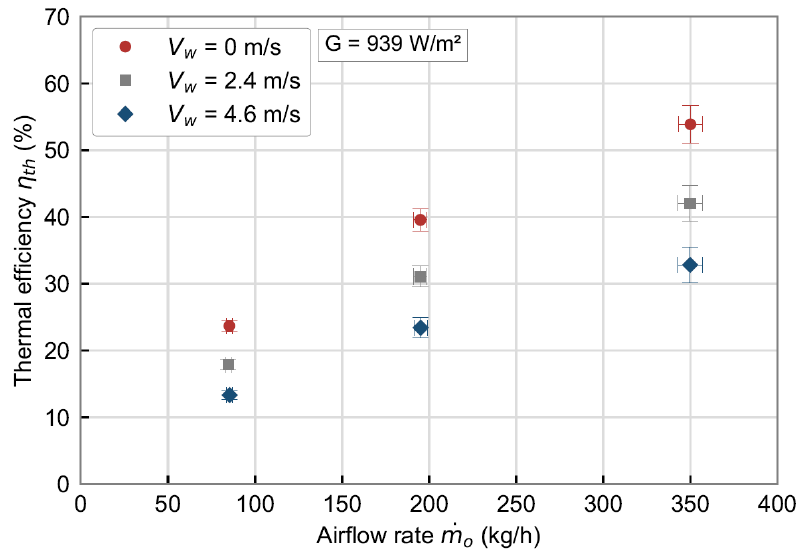
Figure 10. Thermal efficiency dependency to flowrate and wind speed.